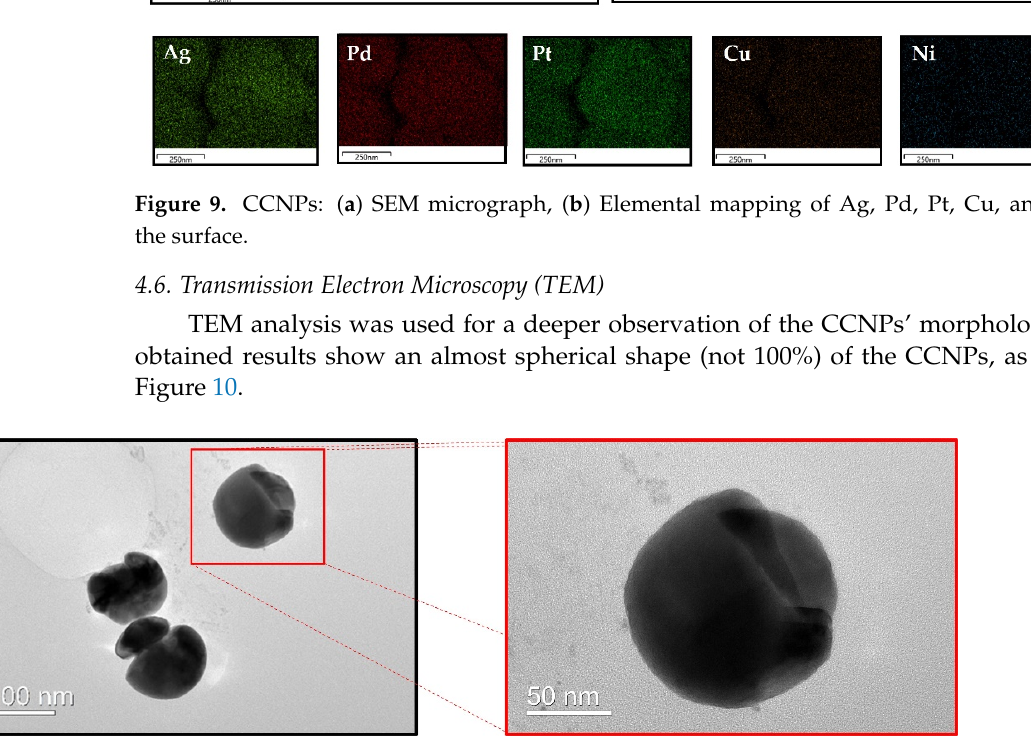
Figure 9. CCNPs: ( a ) SEM micrograph, ( b ) Elemental mapping of Ag, Pd, Pt, Cu, and Ni on the surface.